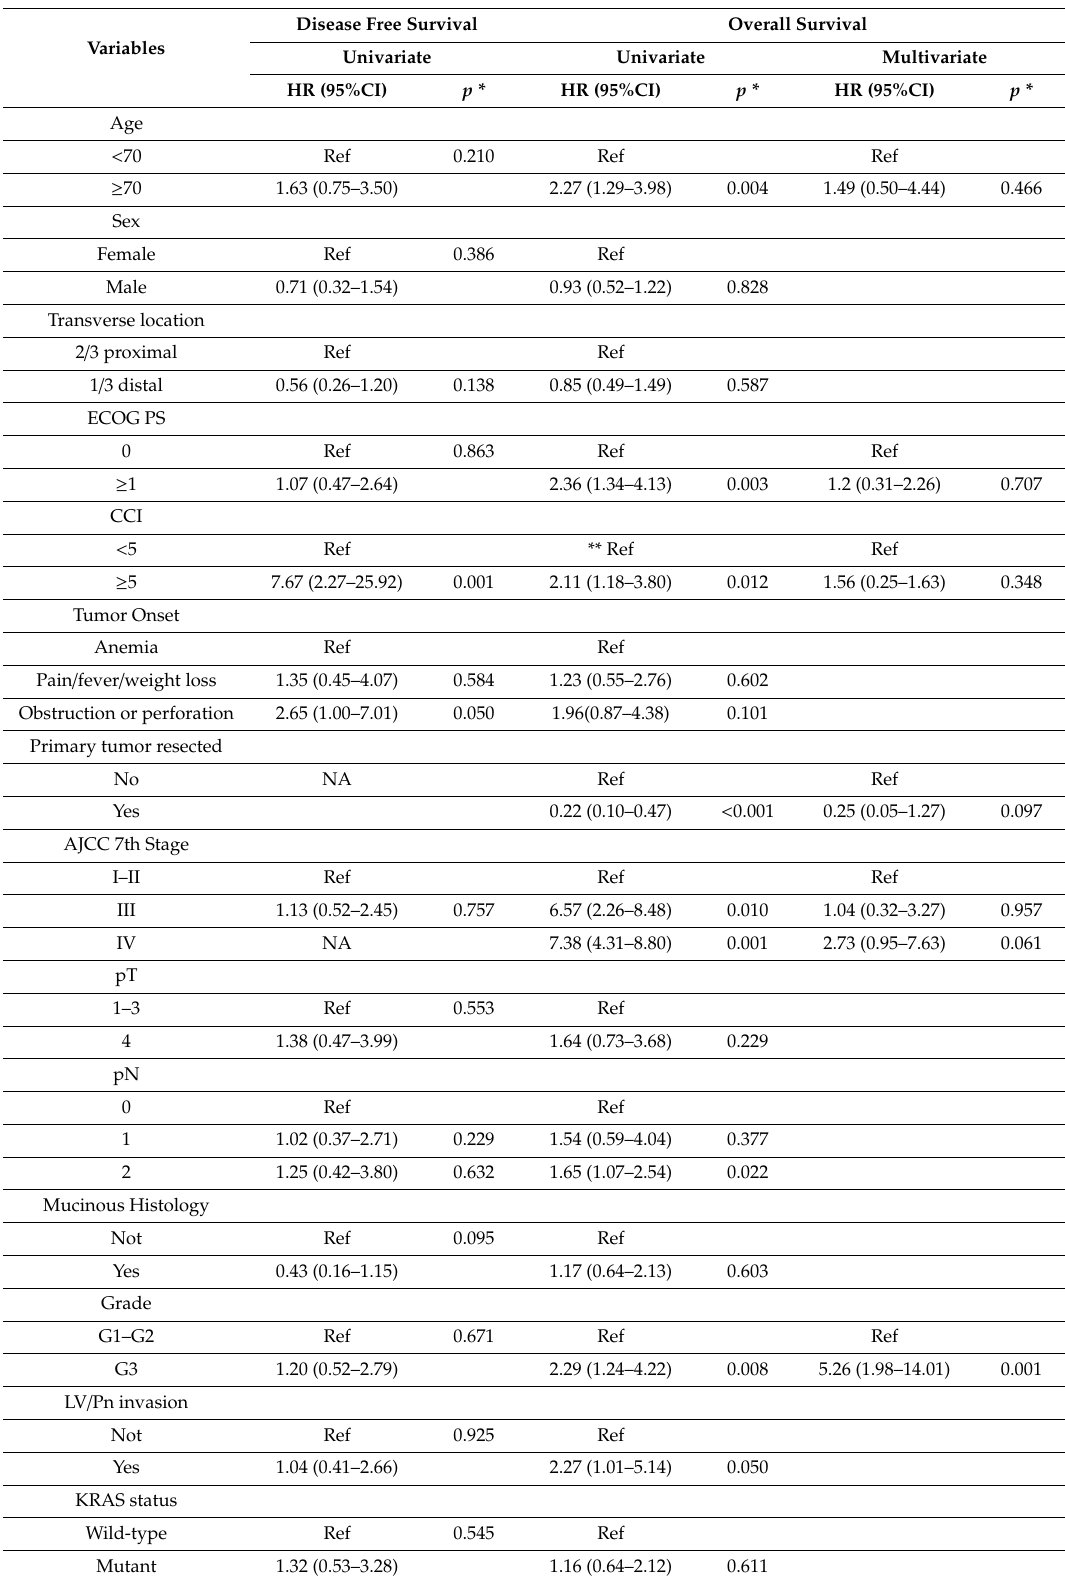
Table 2. Univariate and multivariate analyses of disease free survival ( n = 49) and overall survival in the study cohort ( n =